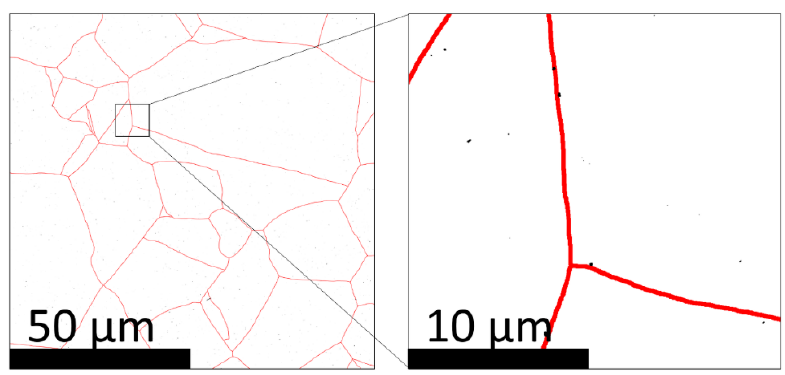
Figure 6. Correlation of precipitates and prior austenitic microstructure for Sample 1.